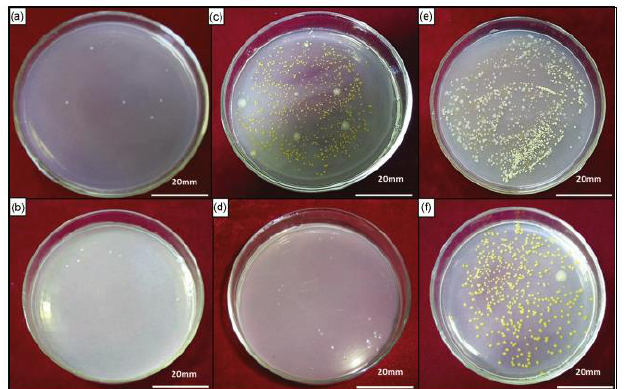
Figure 3. Photos of bacterial colonies on different stainless steels after immersion in the tap water for different durations: ( a ) 304 for 24 h, ( b ) 304-Cu for 24 h; ( c ) 304 for 48 h, ( d ) 304-Cu for 48 h; ( e ) 304 for 72 h, ( f ) 304-Cu for 72 h